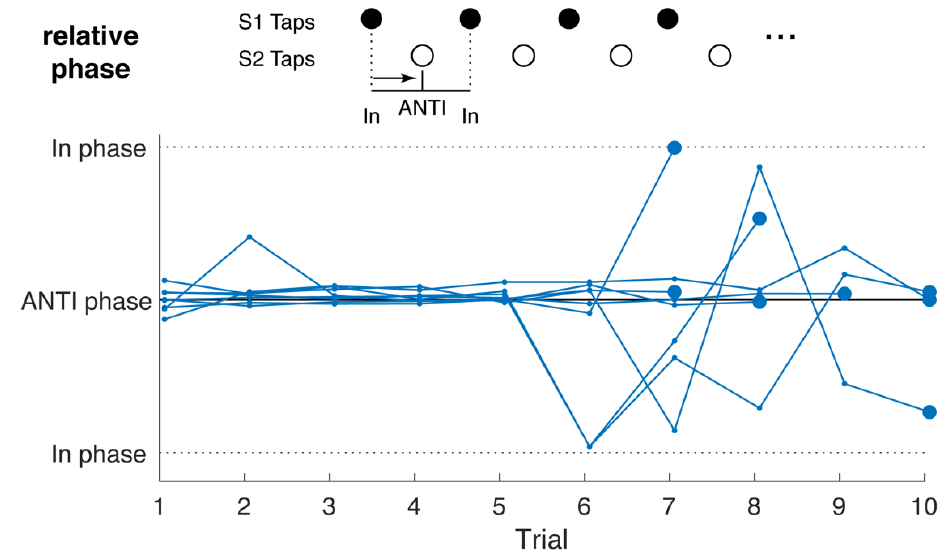
Figure 6. Relative phase per trial for participant dyads. Each dyad ’ s trials comprise blue dots connected by a blue line. The final trial of each dyad is marked in bold.